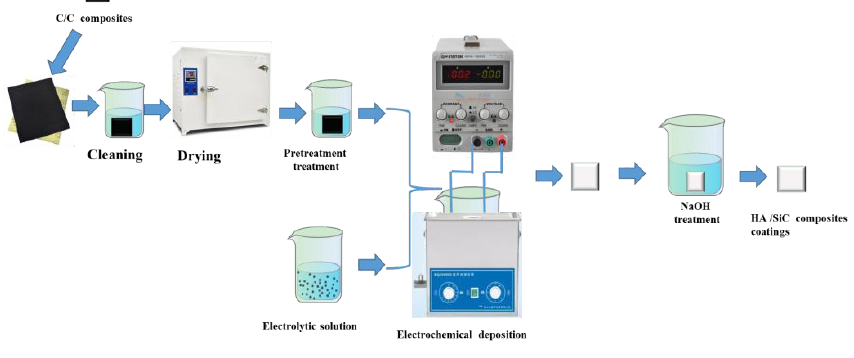
Figure 1. Experimental flow graph.